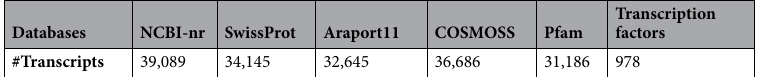
Table 2. Overview of the number of transcripts annotated with different